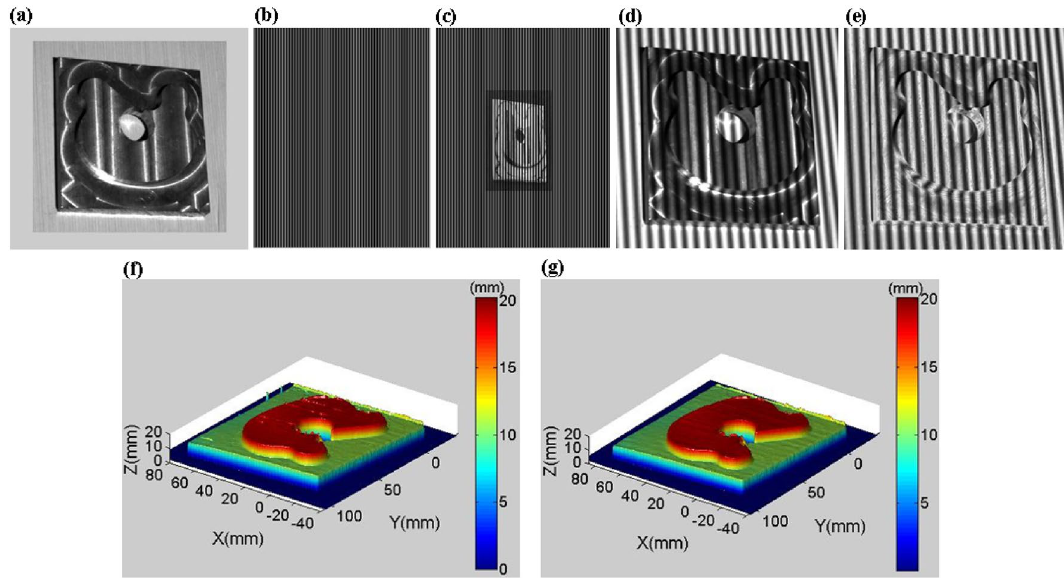
Figure 9. 3-D shape reconstruction of another metal product 2. ( a ) Another metal product. ( b ) Original projection fringe pattern. ( c ) Optimized projection fringe pattern. ( d ) Original captured fringe pattern. ( e ) Optimized captured fringe pattern. ( f ) Reconstructed 3-D surface shape using the original captured fringe patterns. ( g ) Reconstructed 3-D surface shape using the optimized captured fringe patterns.